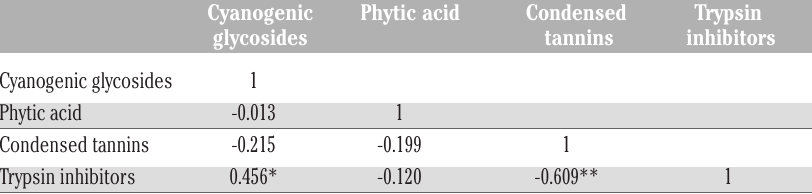
Table 3. Pearson correlation coefficients (r) among antinutritive compounds in seven varieties of Linum usitatissimum .